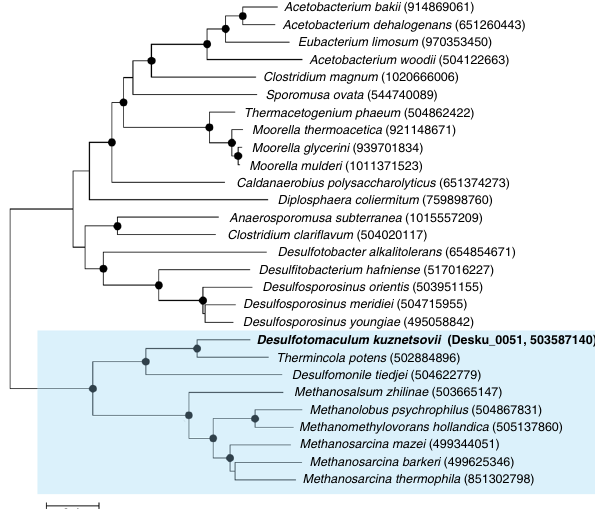
Fig. 3 Neighbor-joining tree based on MtaB amino acid sequences. The sequences were obtained from a BLASTp analysis, using MtaB of D. kuznetsovii as the query sequence. MtaB of D. kuznetsovii is printed in bold. Closed circles represent bootstrap values of 75% or higher. Scale